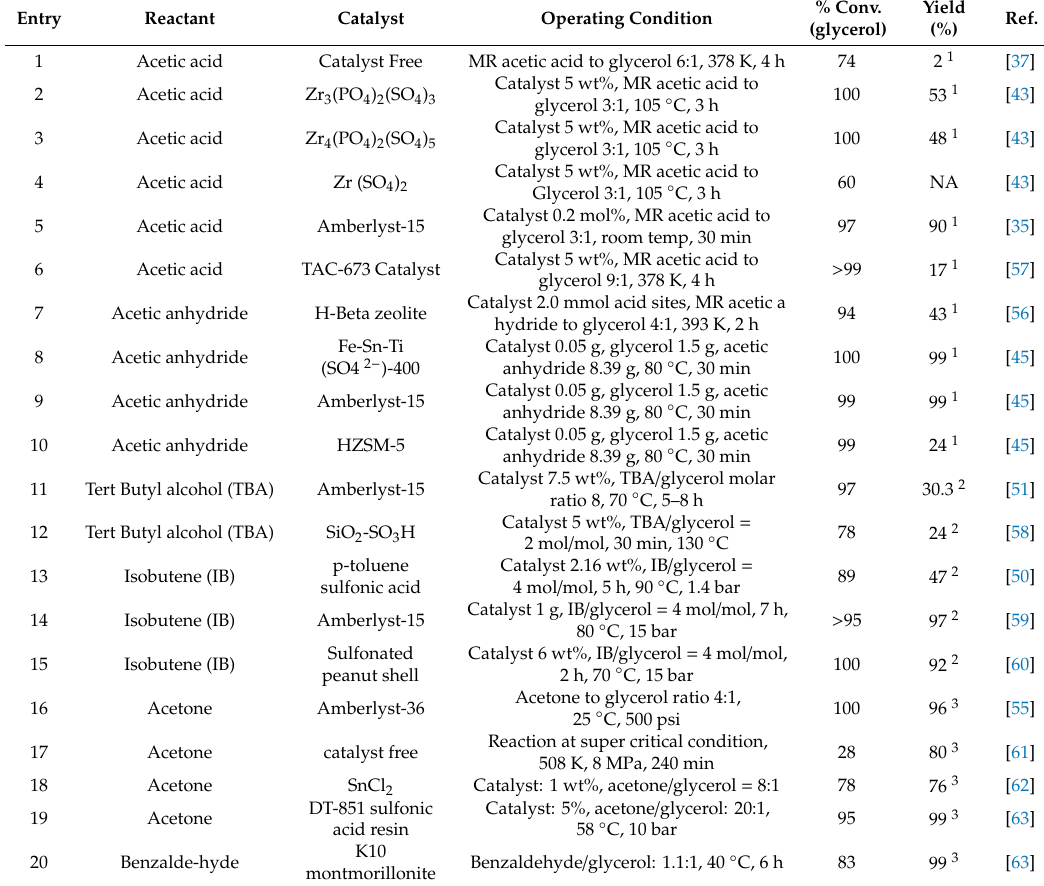
Scheme 5. Conversion of glycerol to glycerol formal. Table 1. Summary of reactants and catalysts used for oxidative fuel additives Table 1. Summary of reactants and catalysts used for oxidative fuel additives production.